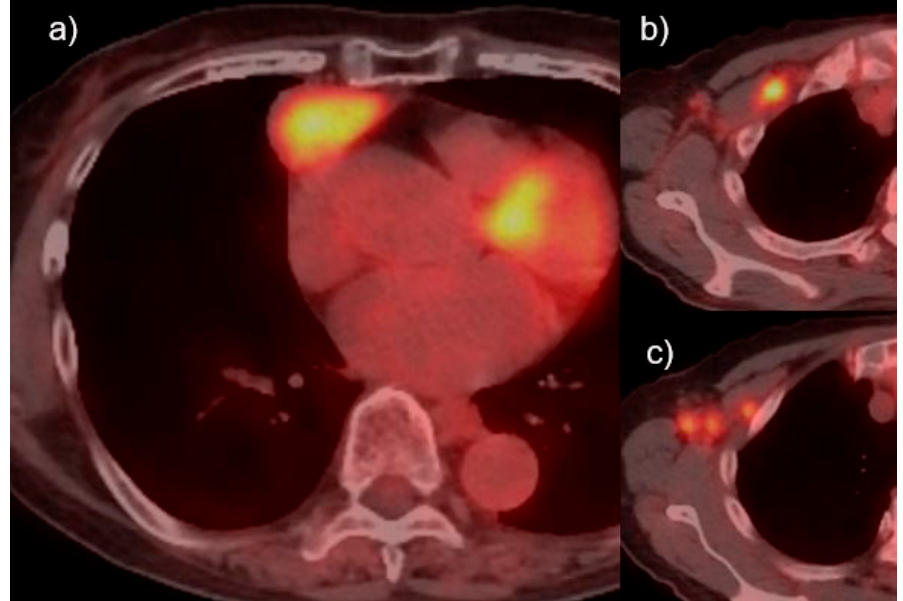
Figure 3. ( a ) An 81-year-old woman case. Anterior mediastinal tumor was shown in a 58 × 45 × 26 mm with fluorodeoxyglucose (FDG) accumulation (maximum standardized uptake value (SUVmax) 6.5) on fluorodeoxyglucose-positron emission tomography (FDG-PET). ( b ) After 5 months, right supraclavicular fossa and ( c ) right axially lymph nodes diagnosed metastasis were revealed with high FDG accumulation (SUVmax 6.6).